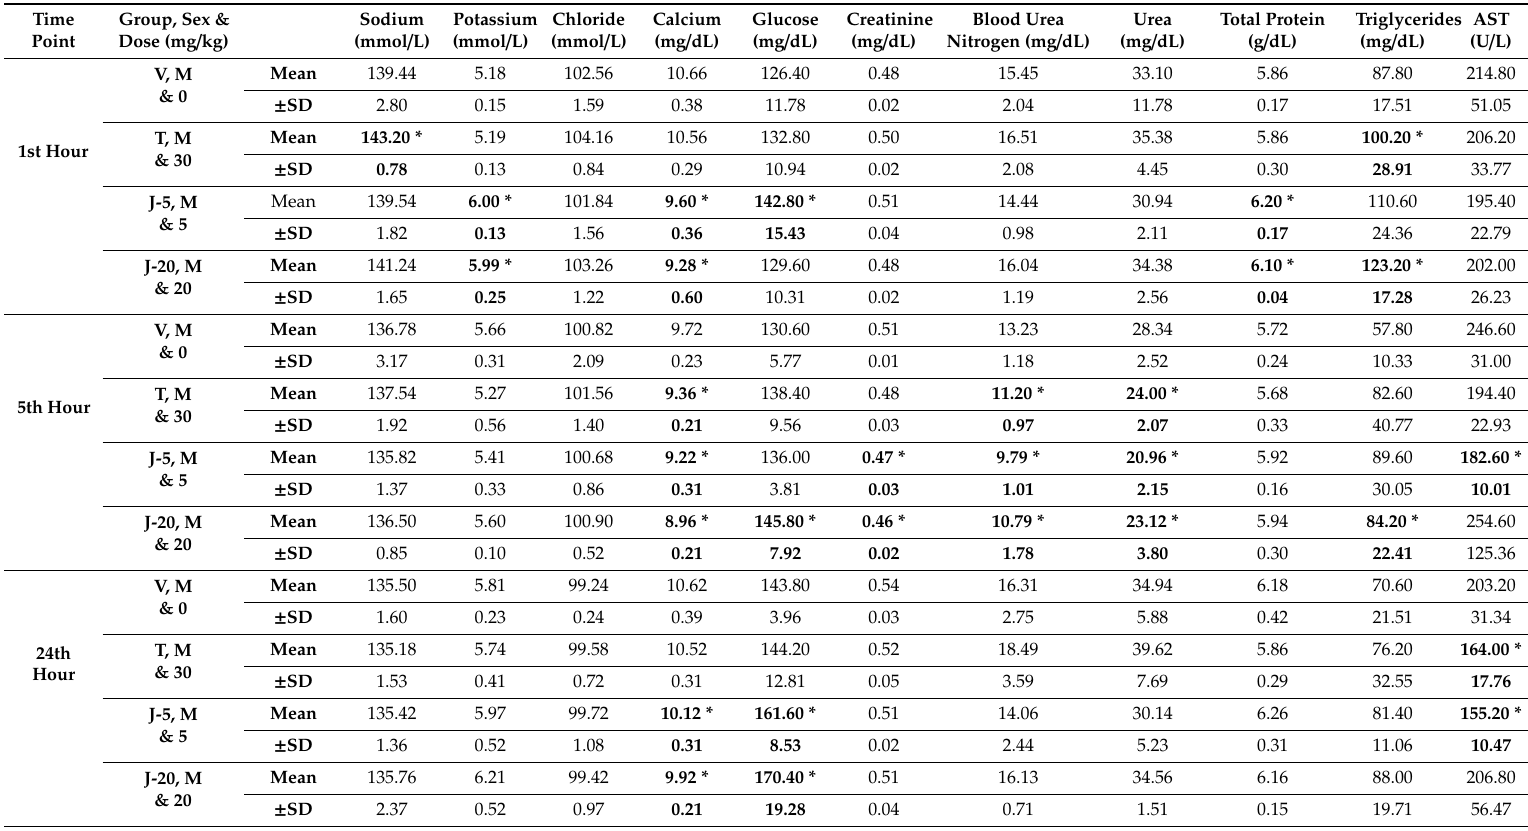
Table A1. Summary of Serum Chemistry